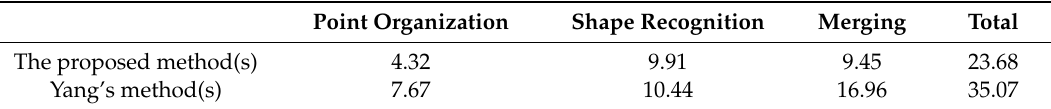
Table 4. Time performance of the proposed method and the method of Yang et al. [37]. Point